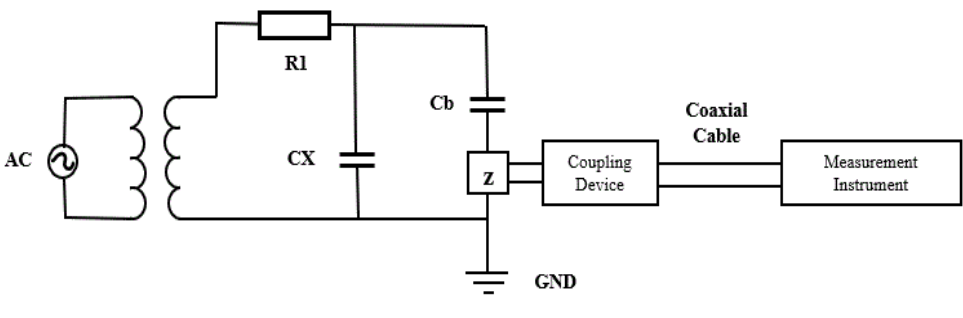
Figure 17. IEC 60270 PD testing circuit .